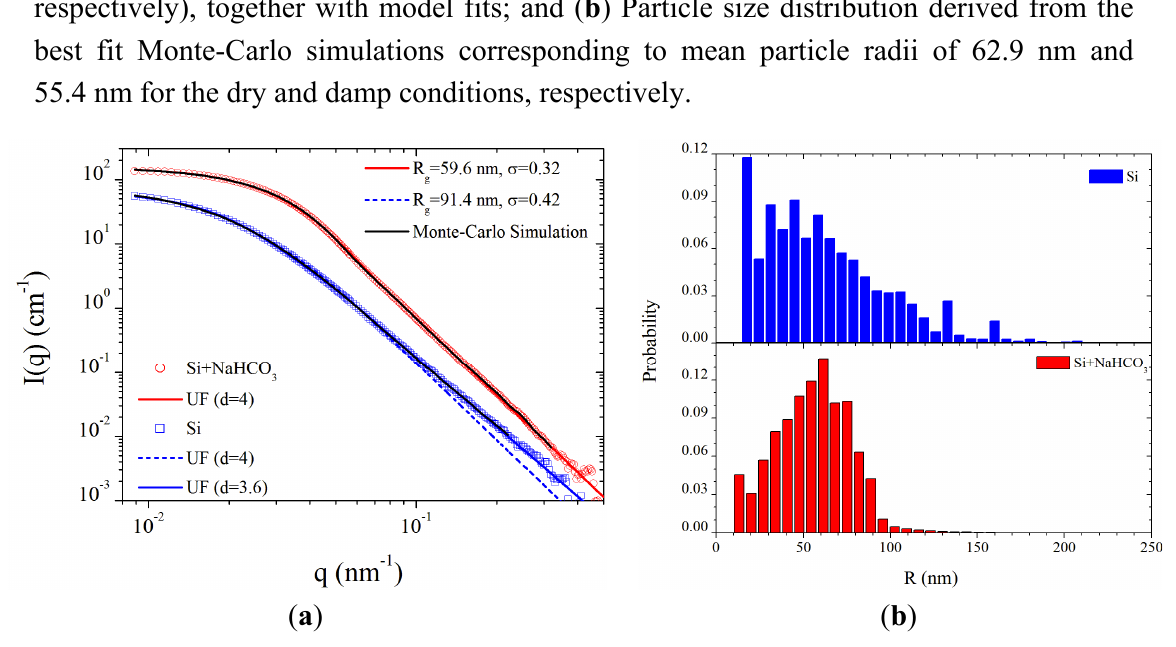
(Blue and Red curves, 3